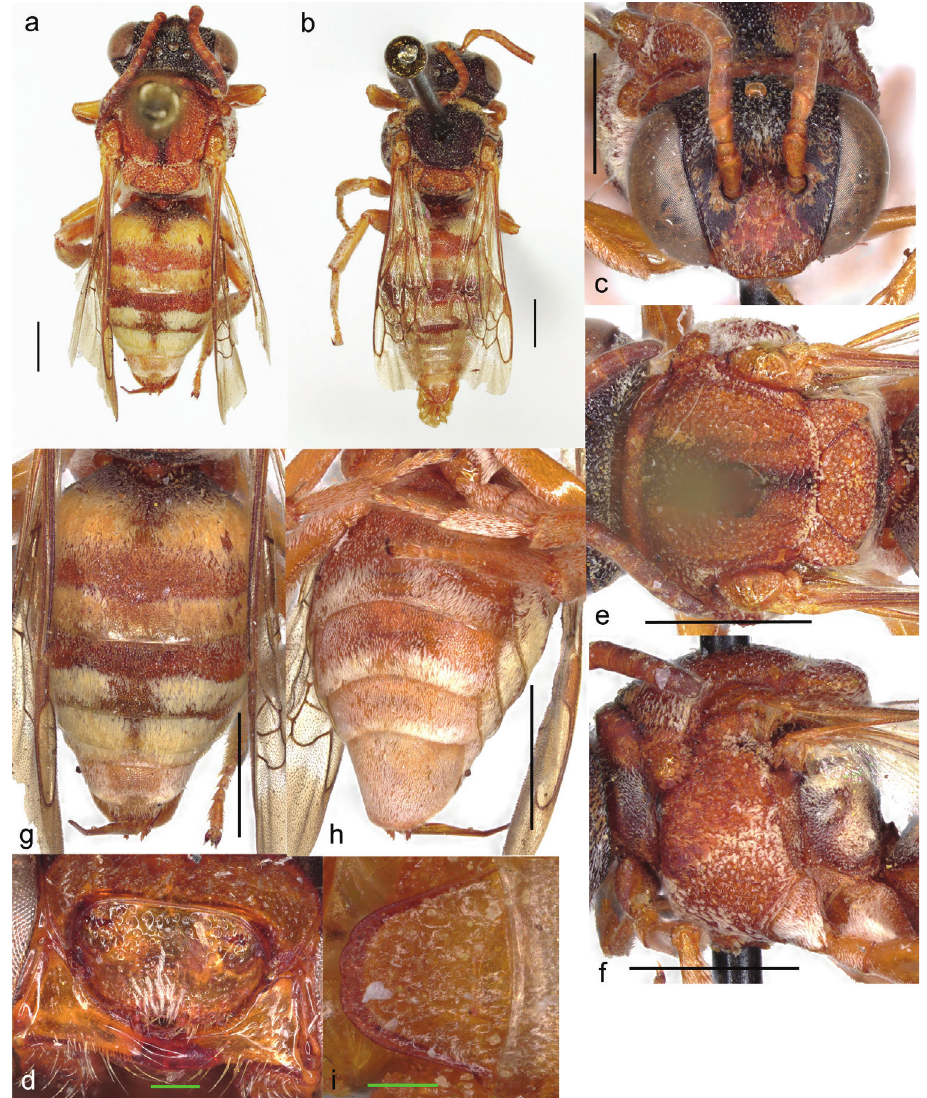
Figure 1. Epeolus iranicus sp. nov. a, c–h holotype, female b, i paratype, male a, b habitus, dorsal view c head, frontal view d labrum, frontal view e mesosoma, dorsal view f mesopleuron, lateral view g meta- soma, dorsal view h ventral view i pygidium, dorsal view. Scale bars: 1.0 mm ( a–c, e–h ); 0.1 mm ( d, i slightly shorter than mesoscutellum. Mesoscutellum with posterior margin extending over propodeum (Fig. 1e). Propodeum brownish, very finely sculptured, matt, and lat- erally with whitish tomentum. Mesopleuron reddish, partly obscured with dense whit- ish tomentum, coarsely and densely punctate, with interspaces shiny and smaller than puncture diameters (but ill visible under the tomentum) (Fig. 1f). Wings brownish